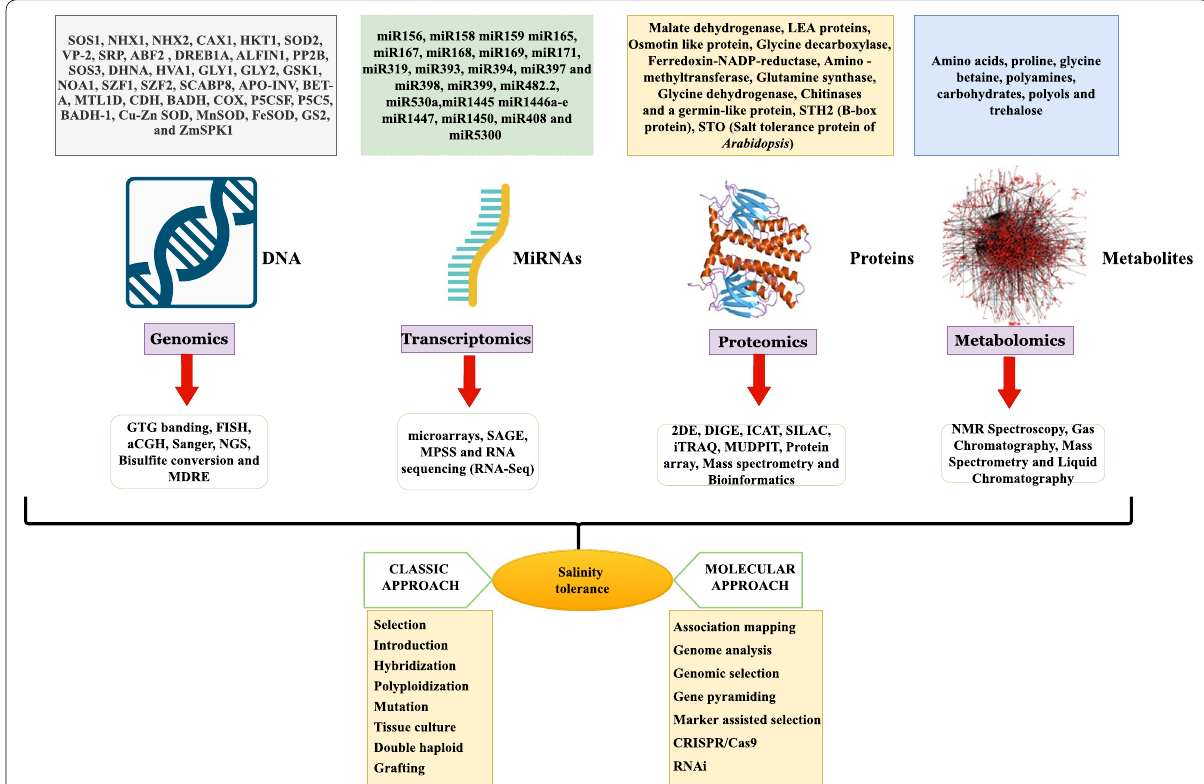
Fig. 2 Diagrammatic representation of different “omics” approaches which are joined to each other at molecular level related with salinity stress tolerance in crop plant. Abbreviations used: SOS1 (Na + /H + antiporter); NHX1 & NHX2 (Na + /H + antiporter); CAX1 (cation/proton antiporter); HKT1, SOD2 (vacuolar Na + /H + antiporter); VP-2 (vacuolar Na + /H + antiporter); Srp (serine-rich protein); ABF2 (ABRE-binding bZIP transcription factor); DREB1A (transcription factor); ALFIN1 (zinc finger transcription factor); PP2B (signalling regulator); SOS3 (calcium-binding protein); PpDHNA (dehydrin protein); HVA1 (group 3 late embryogenesis abundant protein gene); Gly1 and Gly2 (glutathione-based detoxification of methyl glyoxal); AtGSK1 (homologue of GSKS3 /shaggy-like protein kinase); Atnoa1 (impaired nitric oxide synthesis); AtSZF1 & AtSZF2 (CCCH-type zinc finger protein); SCABP8 (interacts with SOS2); Apo-Inv (apoplastic invertase); bet A (choline dehydrogenase), mtl1D (mannitol-1-phosphate dehydrogenase); CDH, BADH (glycine betaine synthesis); Cod A (glycine betaine synthesis); COX (choline oxidase (glycine betaine synthesis)); Mtl1D (mannitol-1-phosphate dehydrogenase); p5csF (proline synthesis); mt1D & Gut D (mannitol-1-phosphate dehydrogenase and glucitol-6-phosphate dehydrogenase); P5C5 (pyrroline carboxylate synthase (proline synthesis)); BADH-1 (betaine aldehyde dehydrogenase); Cu-Zn SOD (copper zinc superoxide dismutase); Mn SOD (manganese superoxide dismutase); Fe SOD (iron superoxide dismutase); GS2 (glutamine synthetase); ZmSPK1 (sucrose non-fermenting-1-related protein kinase) malate dehydrogenase; LEA (late embryogenesis abundant proteins; STH2 (B-box protein); STO (salt tolerance protein of